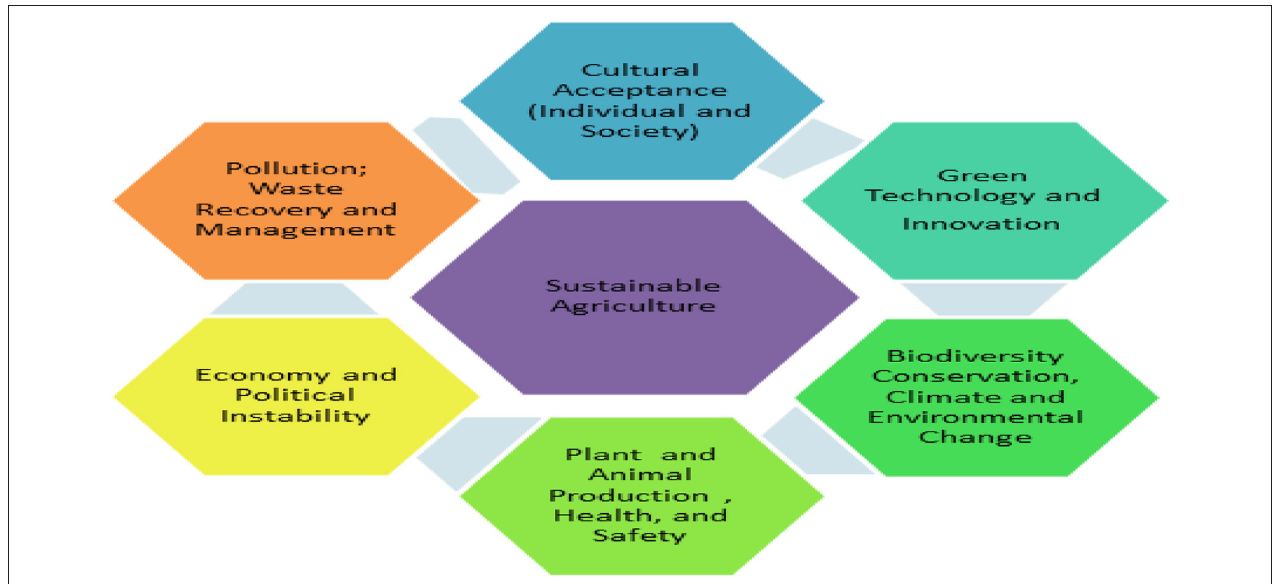
FIGURE 1 | Integration of sustainable agriculture into the